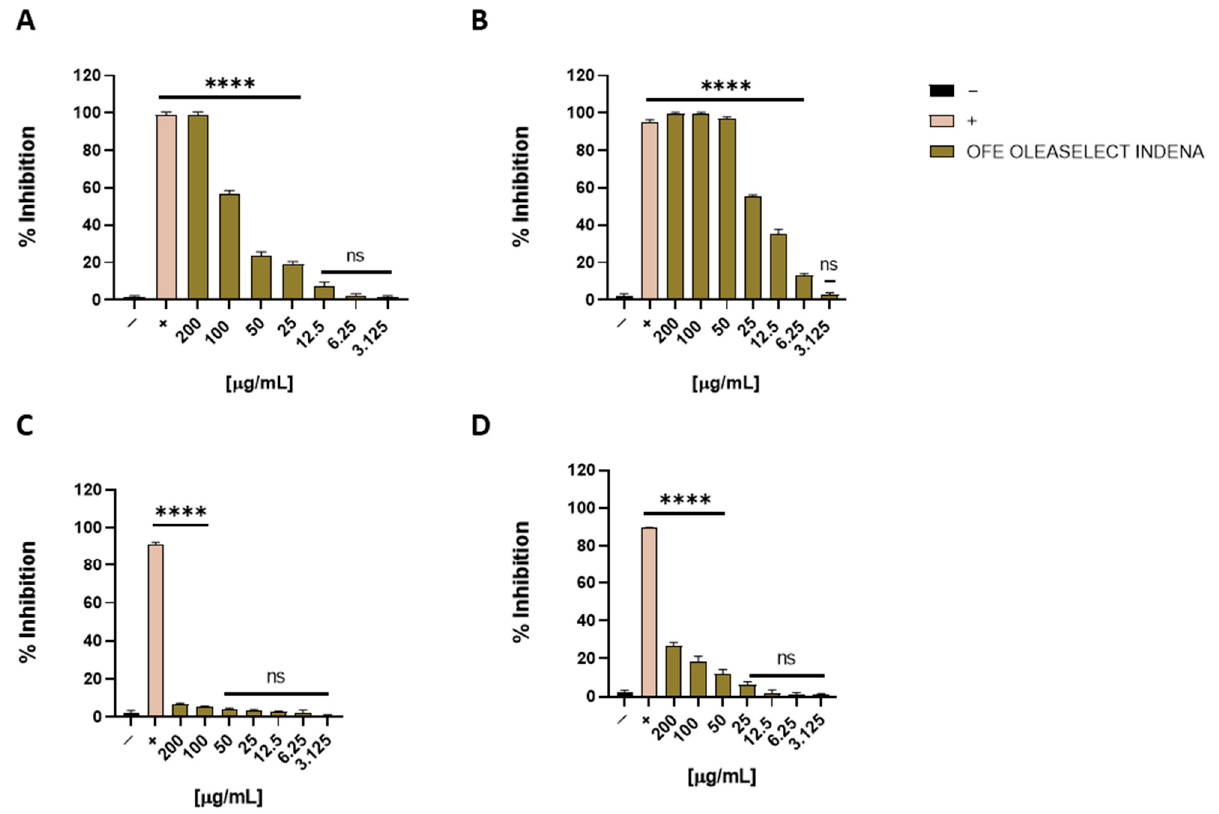
Figure 6. Antiviral activity of OFE against HSV-1. Different assays were performed in order to evaluate anti-HSV-1 activity. ( A ) Co-treatment: simultaneous addition of OFE and virus to the cells; ( B ) Virus pre-treatment: virus incubated with OFE and titrated on the cells; ( C ) Cell pre-treatment: OFE incubated with the cells before the viral infection; ( D ) Post-treatment: OFE added to the infected cells. OFE interfered with the early stages of infection acting in co-treatment ( A ) and virus pre-treatment ( B ) assays, although it was not able to interact with the cellular surface ( C ) or block the viral replication ( D ). Different compounds were used as the positive control (+) for each treatment: Greco grape cane extract [7] ( A , B , 10 µ g/mL for both the assays), dextran sulfate ( C , 1 µ M), and acyclovir ( D , 5 µ M), whereas infected cells were used as the negative control ( − ). Statistical analyses were determined by ANOVA with Dunnett’s test for multiple comparisons. Significances are referred to as the negative control (–). **** p < 0.0001; ns: non ‐ significant.